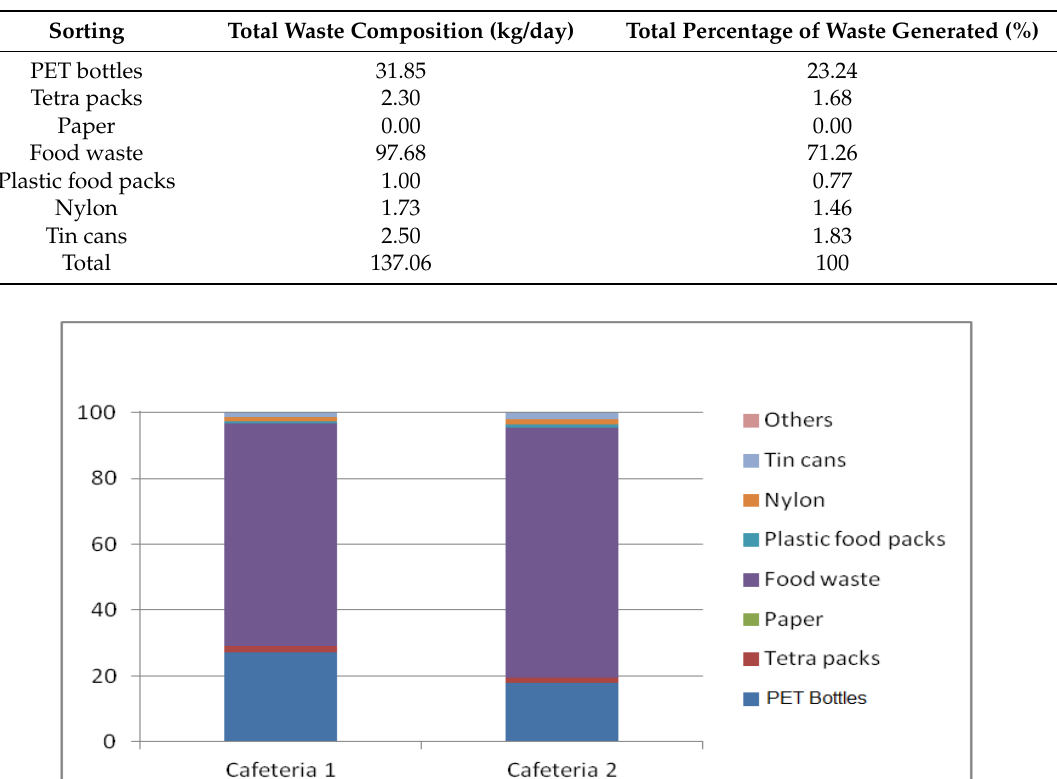
Table 7. Total waste generated in both cafeterias 1 and 2.